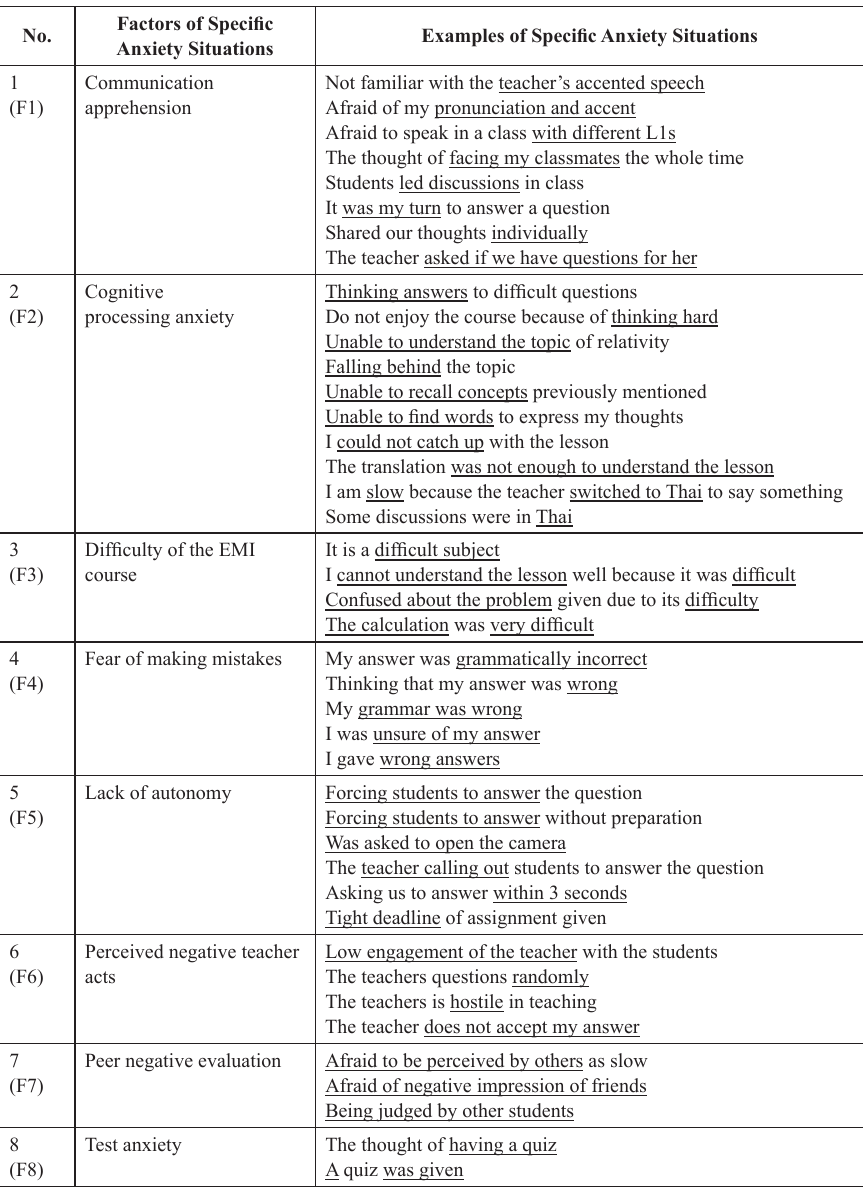
Table 2. Factors of specific anxiety